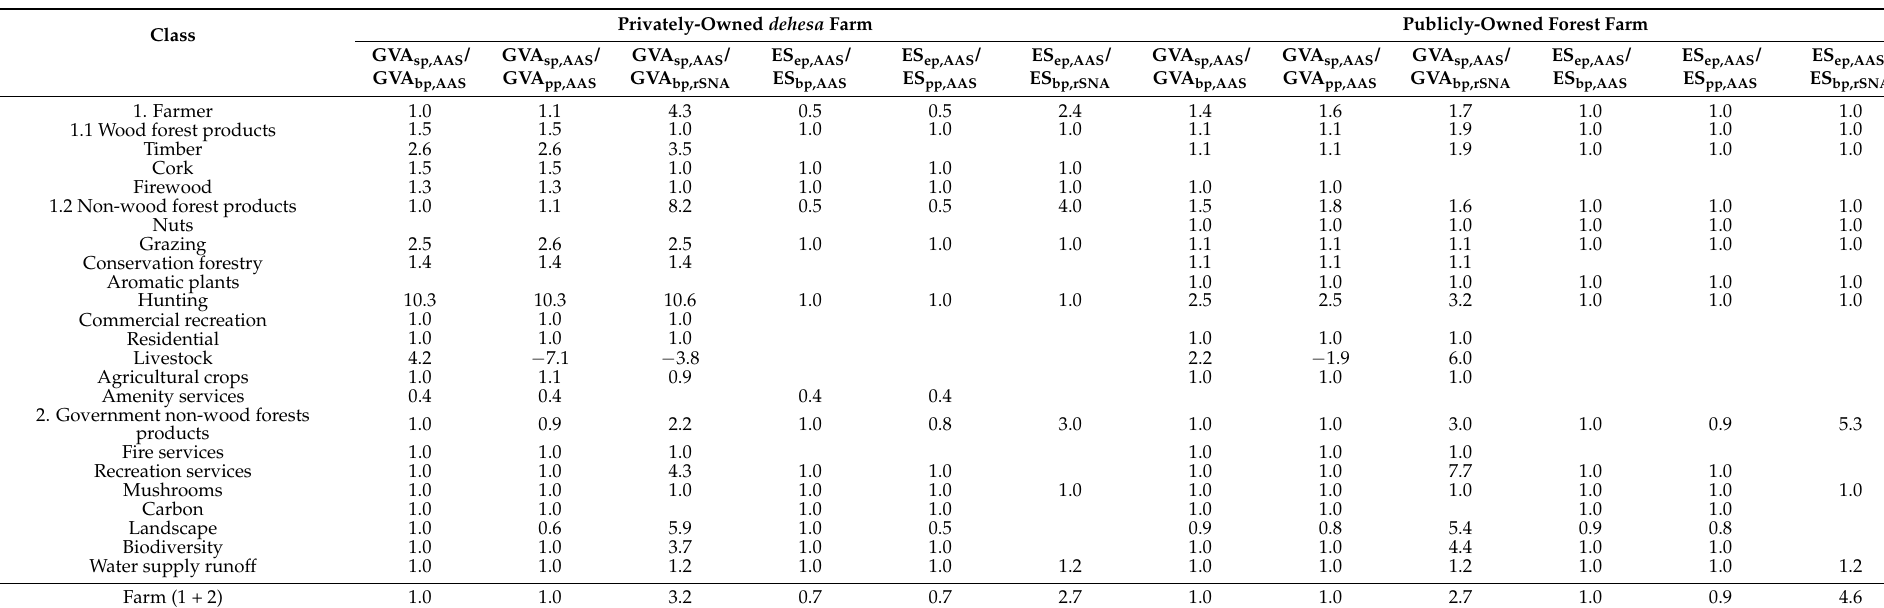
Table 9. Comparison of gross value added and ecosystem services of the case-study large dehesa and forest farms in Andalusia under the AAS and the rSNA